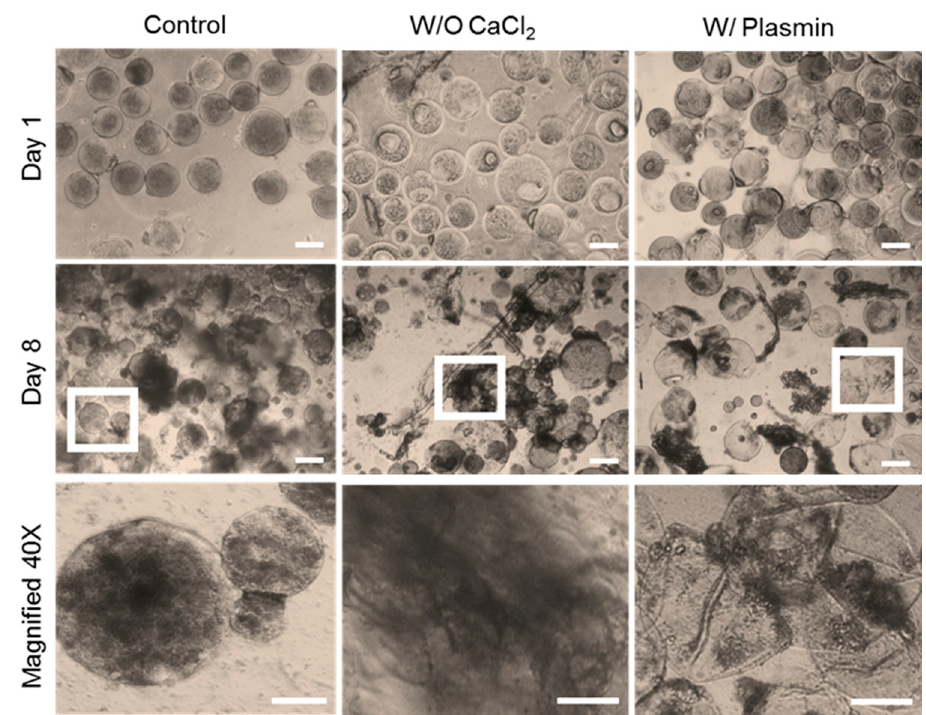
Figure 9. Degradation of PRP-loaded microspheres as a function of plasmin addition or absence of Ca 2+ during fabrication. Representative microscopic images of microspheres were taken on day 1 and 8. Scale bar is 100 µm for day 1 and day 8; scale bar is 50 µm for magnified images, day 8. Microspheres were prepared with 4-arm PEG–Ac and PEGDD-1 as a crosslinker at 7.5% w/v in PEG. Powder PRP was loaded at 10% w/v.